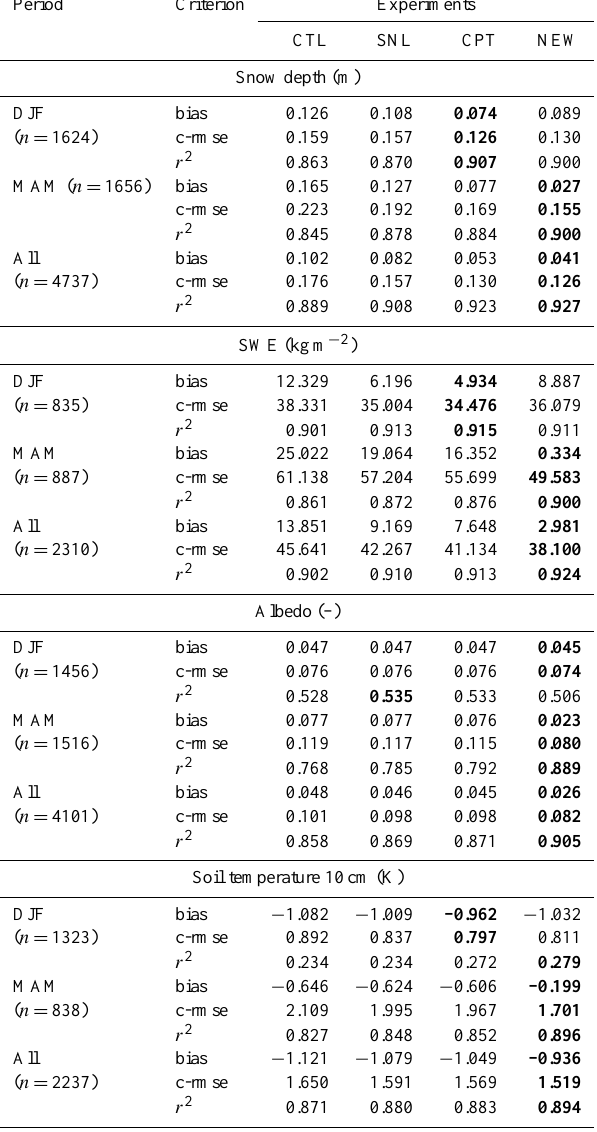
Table 2. Daily skill scores simulated by each experiment at Col de Porte for snow depth, SWE, albedo, and soil temperature at 10cm over the number of point measurement, n . The bias, centered root mean square error (c-rmse) and square correlation ( r 2 ) described in Sect. 4.1 are shown. The best scores are given in